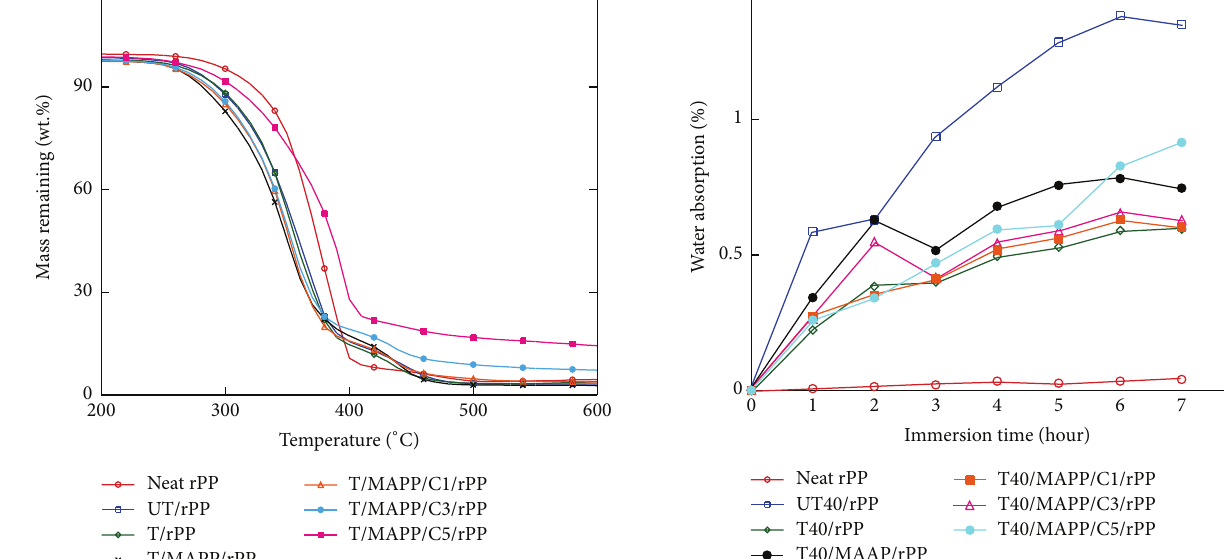
Figure 6: Effect of fiber treatment and nanoclay on TGA curves of rPP and SF/rPP composites.